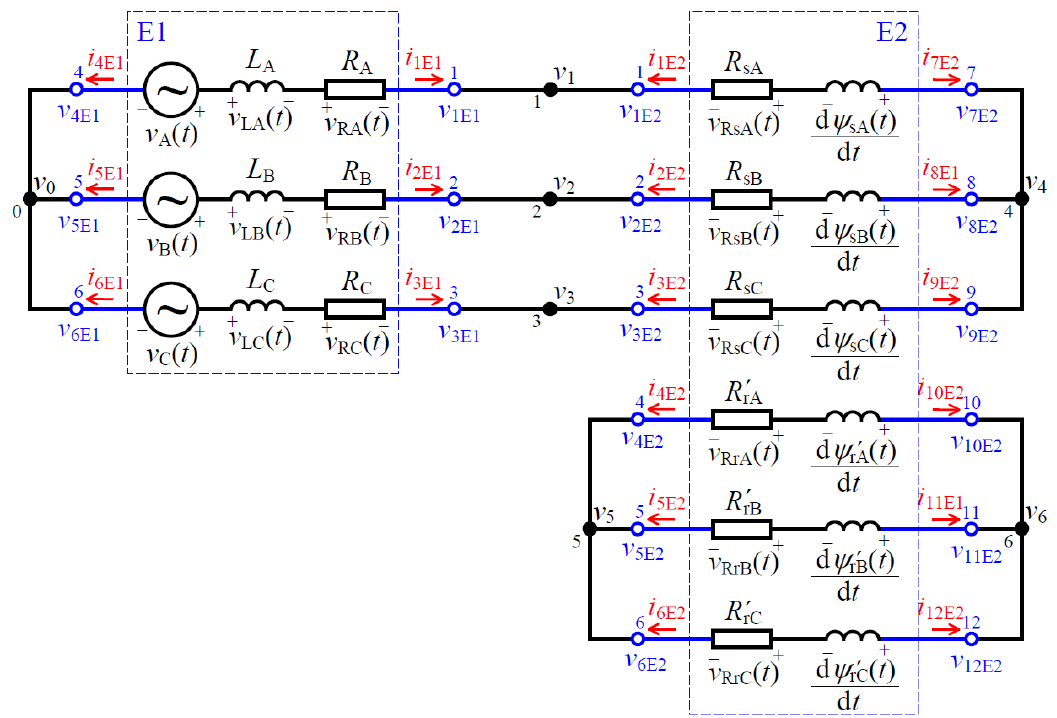
Figure 5. Substitute diagram of the analyzed electromechanical system with division into structural elements.